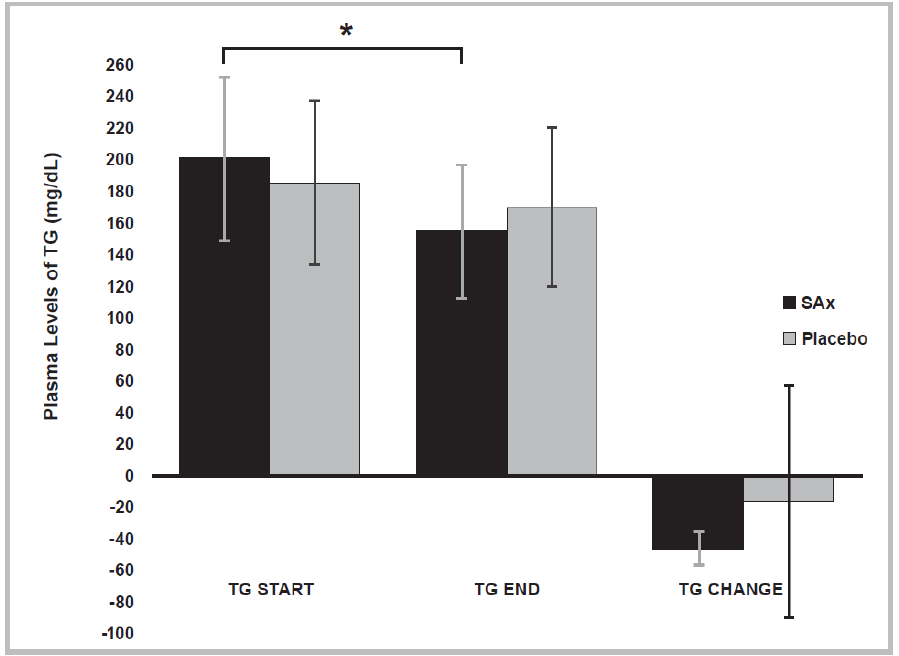
Figure 4. Plasma levels of triglycerides (TG) significantly decreased following SAx treatment (oral supplementation with hydroxytyrosol (HT) and punicalagin (PC)) (black color) in subjects with hypertriglyceridemia, a risk factor for CVD, ( n = 4) (* p < 0.05). This effect was not observed after placebo treatment (gray color). The data